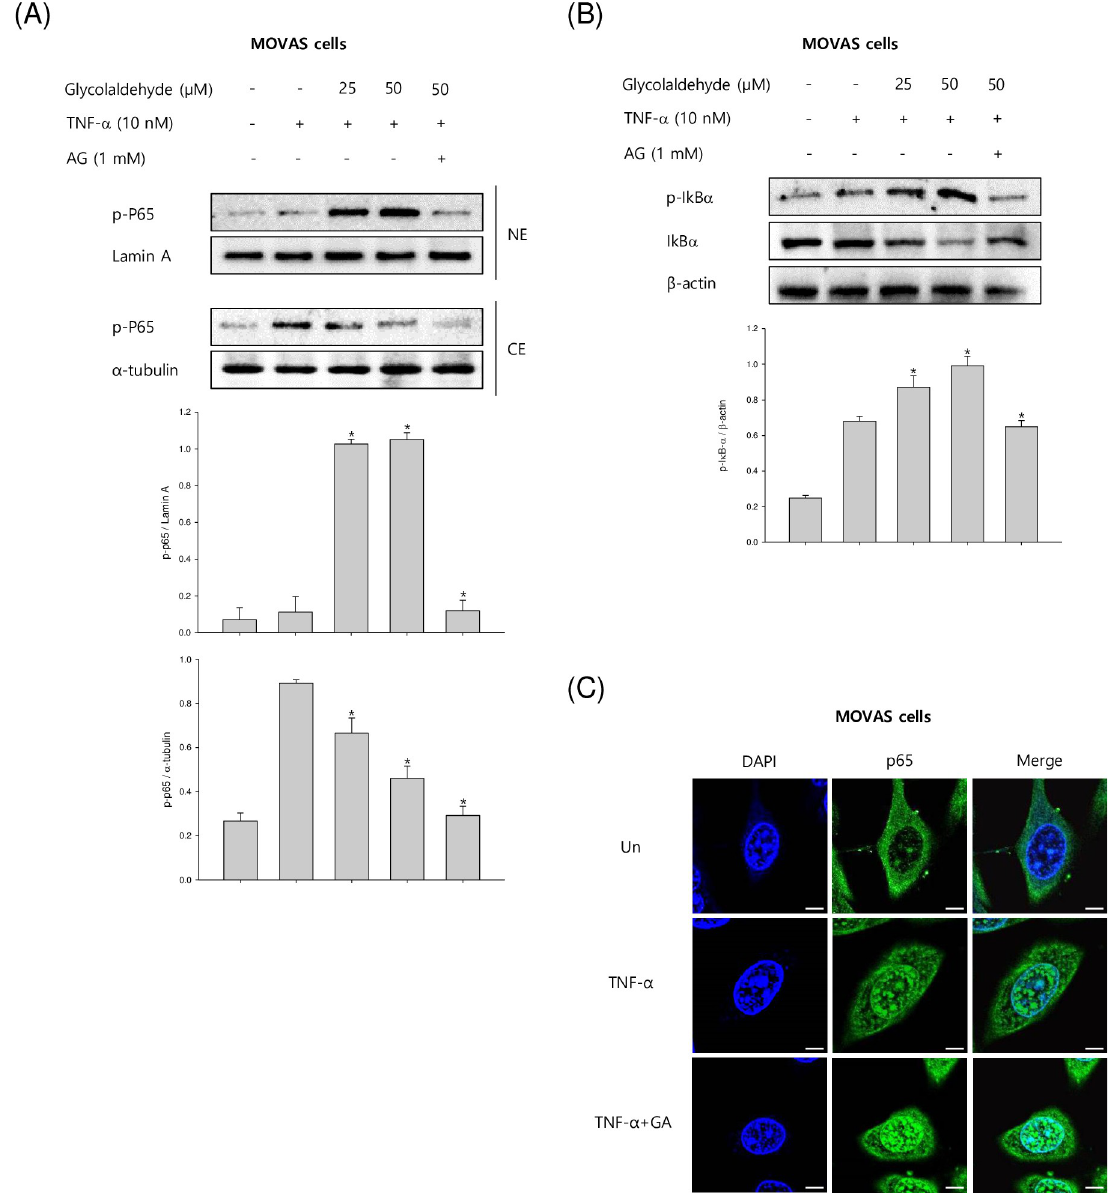
Fig 3. Effects of GA on TNF- α -induced activation and translocation of NF- κ B in VSMCs. (A, B) The mouse VSMCs, MOVAS-1 cells, were stimulated with TNF- α (10 ng/mL) in the presence or absence of GA (25 and 50 μ M) for 4 h. The nuclear protein levels of p65 and I κ B α were identified by Western blot assay to demonstrate the translocation of NF- κ B p65. (C) MOVAS-1 cells were stimulated with TNF- α (10 ng/mL) in the presence or absence of GA (25 and 50 μ M) for 4 h. After stimulation, the cells were incubated with the NF- κ B p65 primary antibody followed by FITC-labeled anti-rabbit IgG antibody. The cells were observed using fluorescence microscopy at 600 × magnification. The level of lamia A and α -tubulin was measured for nuclear and cytosol as an internal control, respectively. Results are shown as means ± SEM from a representative experiment (n = 5). � p < 0.05 significantly different from the group treated with TNF- α